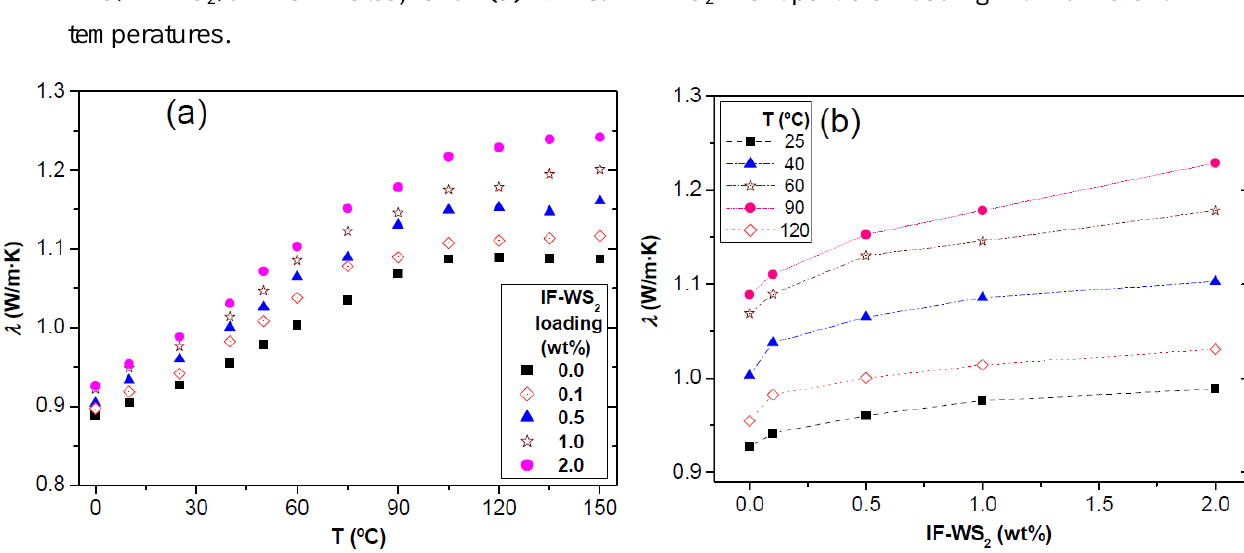
Figure 5. ( a ) Comparison of the thermal conductivity ( λ ) as a function of temperature for PPS/IF-WS /CF laminates; and ( b ) λ vs. IF-WS 2